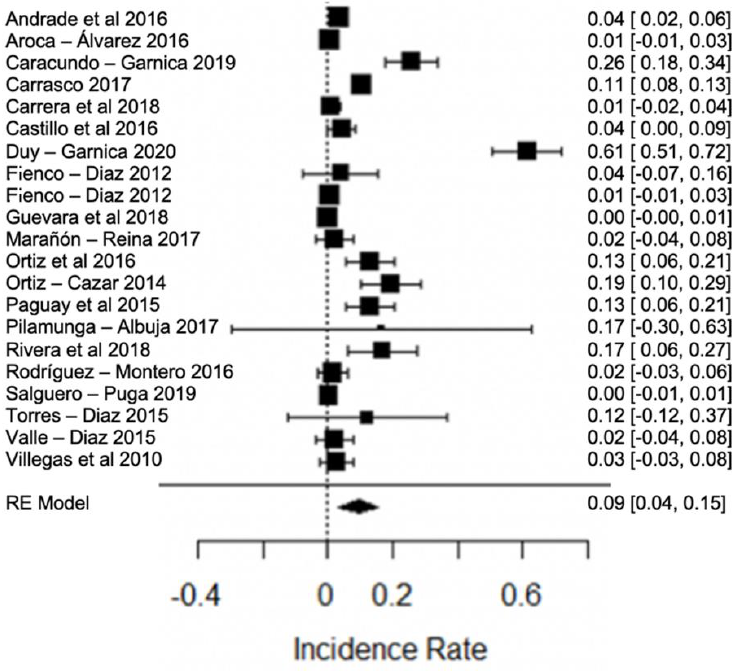
Figure 16. Forest plot of added water [39,61,63].